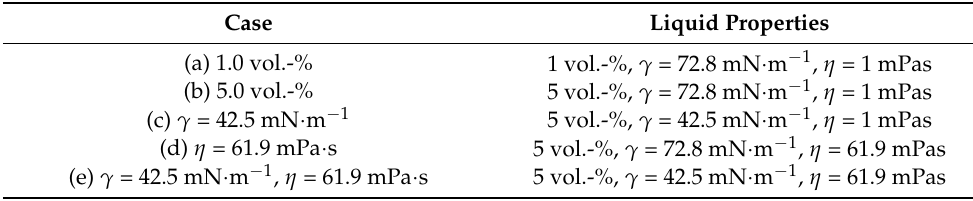
Table 3. The five simulation cases with different liquid loading and properties at a fluidization